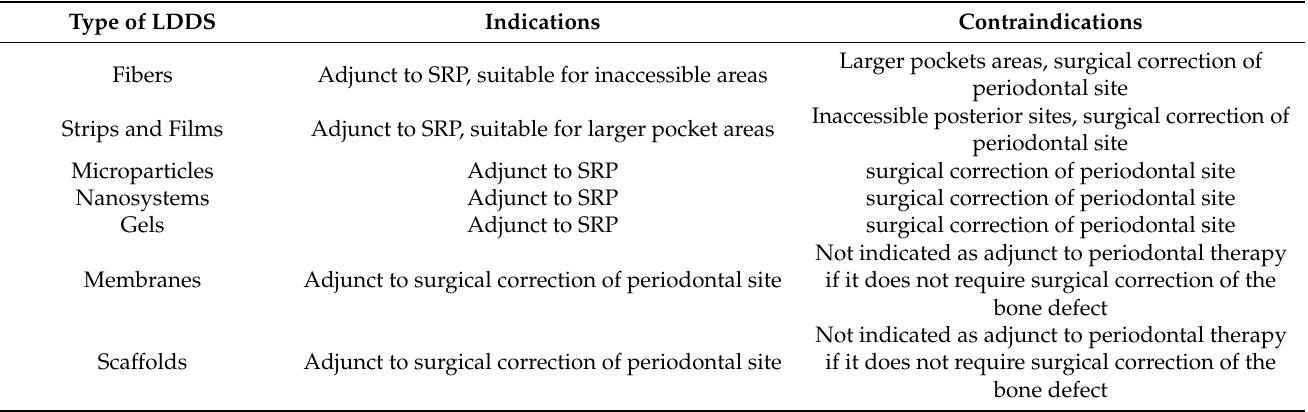
Table 3. Indications and contraindications of each LDDS